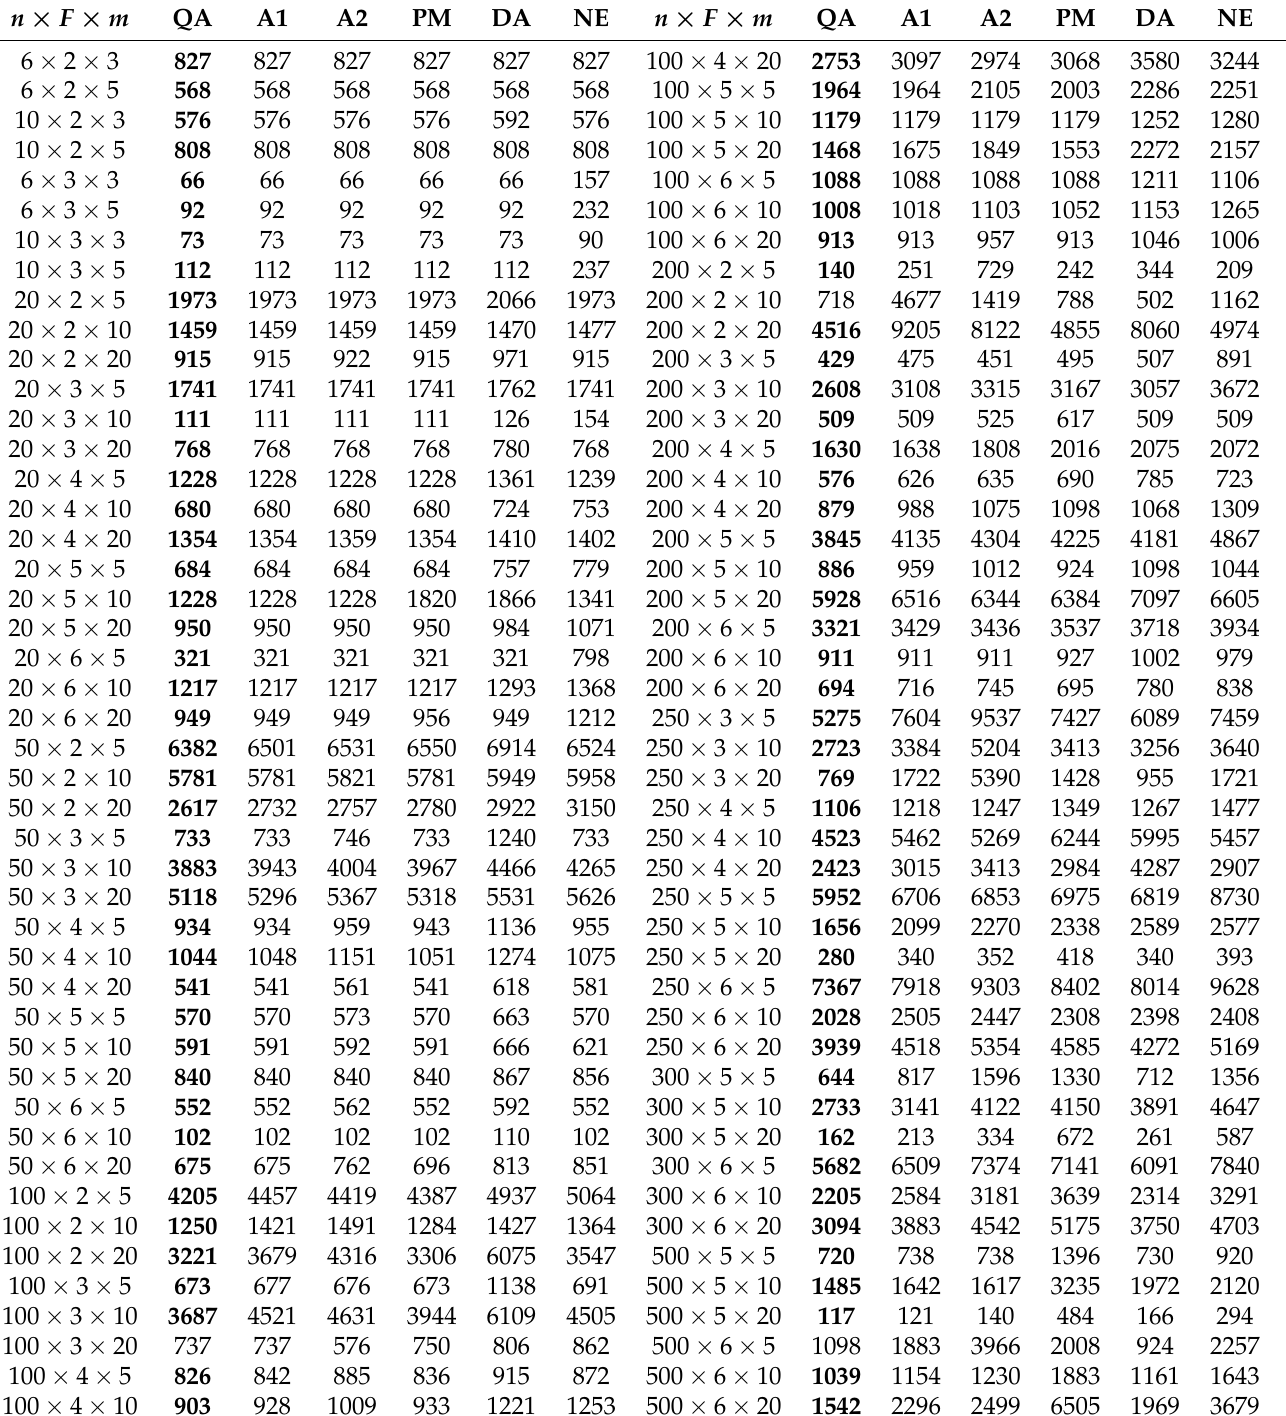
Table 6. Computational results of Min by six